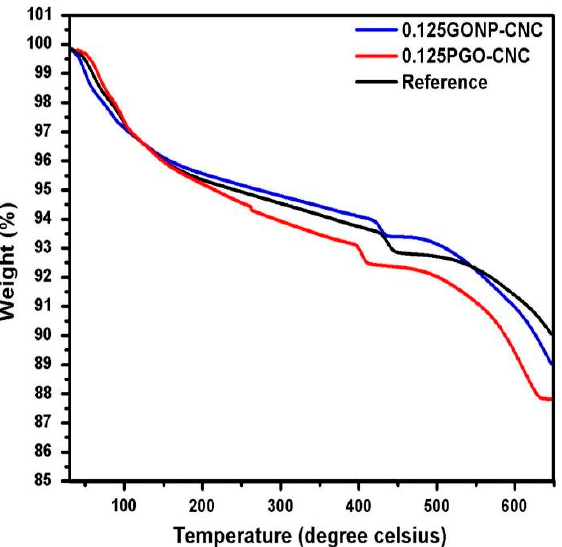
Figure 10. TGA curves of plain mix, pristine graphene oxide mortar composite and graphene oxide mortar composite after 90 days of curing. Reproduced with permission from [107], Elsevier,